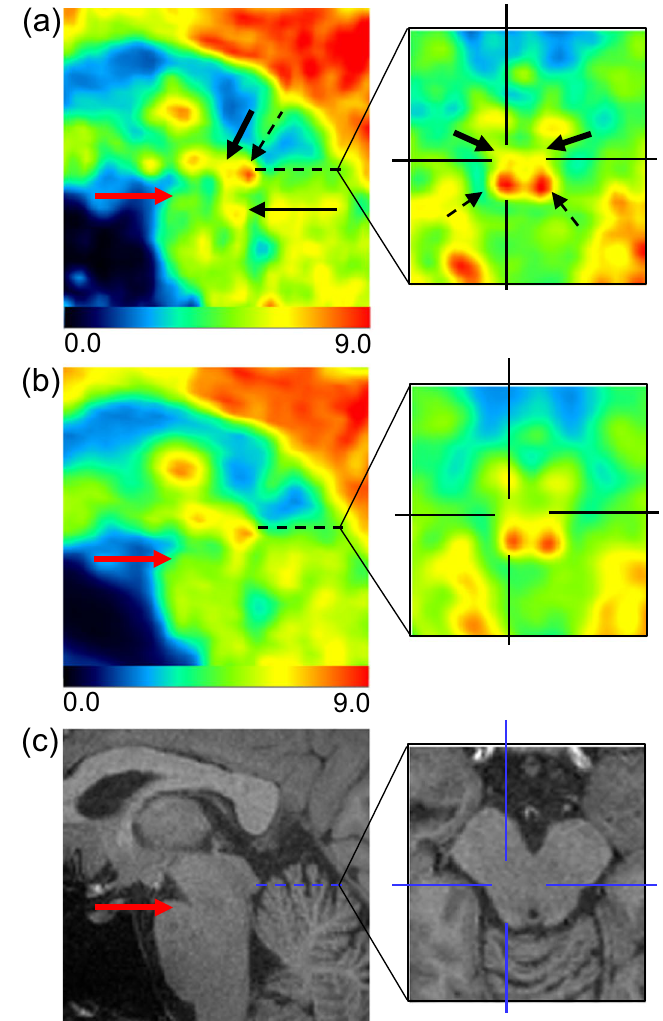
Fig. 4 Sagittal views of the brainstem using Vrain ( a ), whole-body PET ( b ), and MRI ( c ). The right expanded images show the axial images at the level (dashed line in the sagittal image), which is 4 mm above the isthmus (red arrow). The midbrain part of the raphe nucleus (bold arrows) is depicted ventral to the inferior colliculus (dashed arrows) using Vrain ( a ), and the centre of the crossbar is placed at the right component of the raphe nucleus in the midbrain. The pontine part of the raphe nucleus is also visualised on sagittal view (black arrow) ( a ) at 2 mm below the isthmus (red arrow). The raphe nucleus is not visualised on the whole-body PET ( b ). The SUV is indicated by the colour